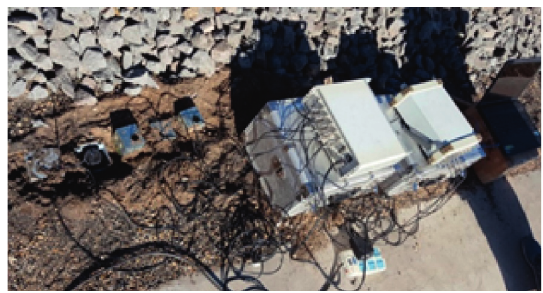
Figure 4: Connection among the instruments.